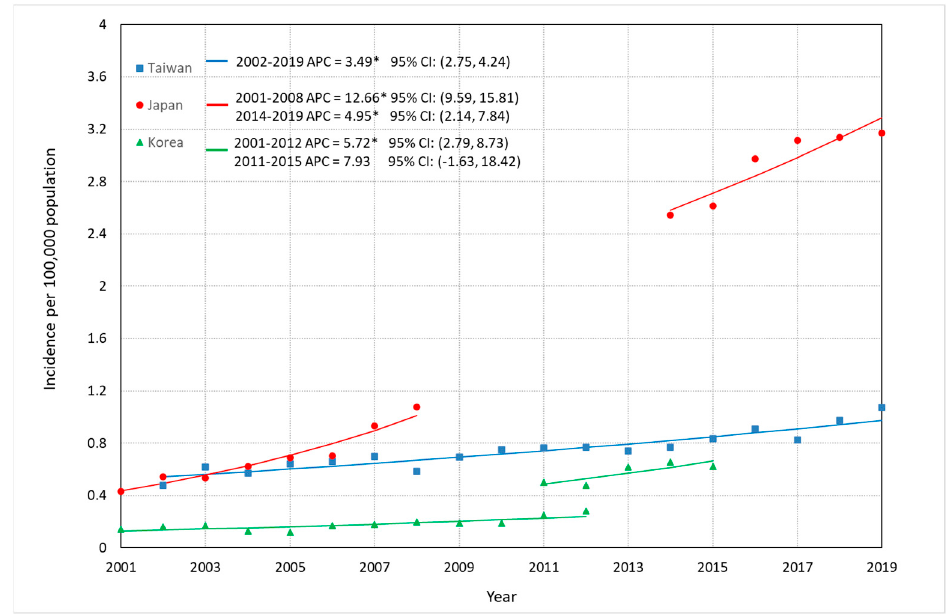
Figure 1. Trends in the ASRs of FL in Taiwan, Japan and Korea. * The APC is significantly different from 0 at the alpha level of 0.05.